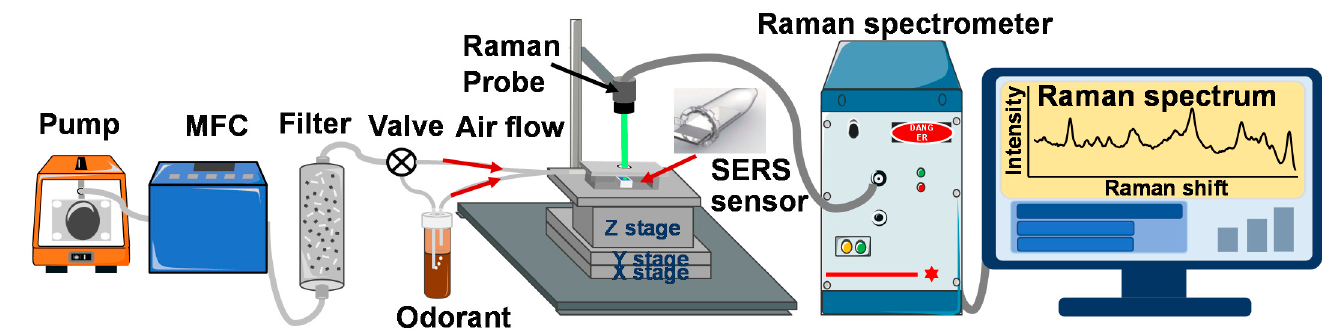
Figure 2. Schematics of the gas generation and detection system.